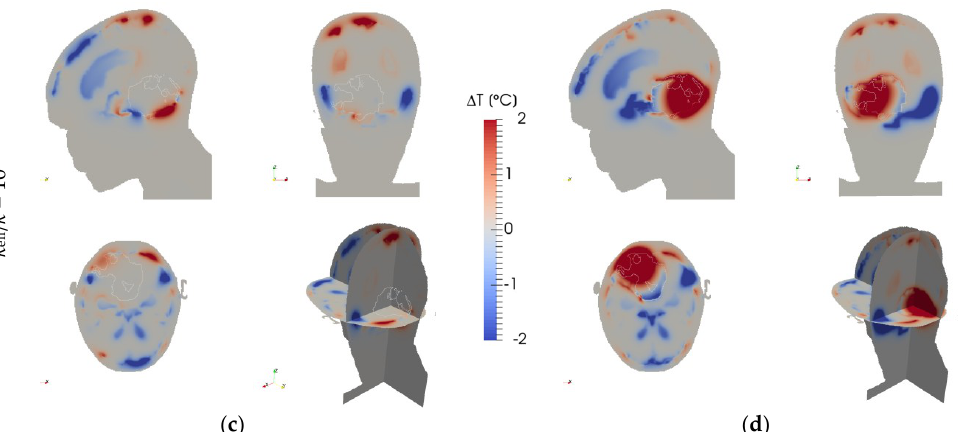
Figure 4. Temperature difference of ( a,b ) the solid and (c ,d ) the high- k ( k eff / k = 10) model with the fluid model for ( a,c ) the pre-operative and ( b,d ) post-operative cases. The panels show planes through the tumour’s centre of gravity in the left-right (top-left), anterior-posterior (top-right), and cranial-caudal (bottom-left) directions, and a 3D view (bottom-right). The tumour (region) is outlined. We simulated the first 30 minutes (1800 s) of a treatment. While a typical hyperthermia treatment may last between 60 and 90 minutes, an equilibrium is reached long before then. The development over time of the T 90 , T 50 , and T 10 , shown for the pre-operative case in Figure 5 for (a) the tumour and (b) the CSF, confirms that an equilibrium is reached within these 1800 s. The cooling effect of the water bolus needs some time to penetrate into the body, which causes the delayed decrease of the T 90 in the CSF after an initial increase. The absence of such a delayed decrease in the tumour graph indicates that tumour temperature is not affected by the water bolus temperature. An analysis of the complete temperature distribution confirms that temperatures below 37 °C are only found in the outer 0.5–1.0 cm of the skull.